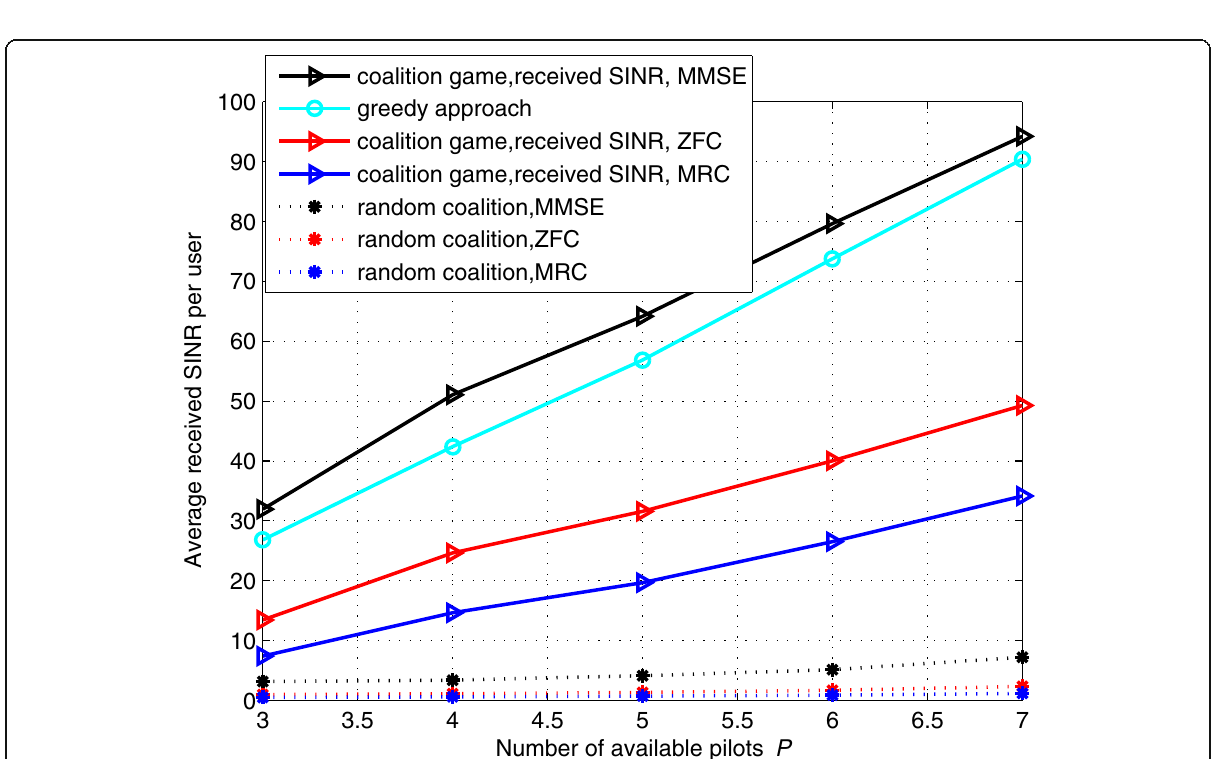
Fig. 11 Average received SINR versus the number of pilots with T = 20